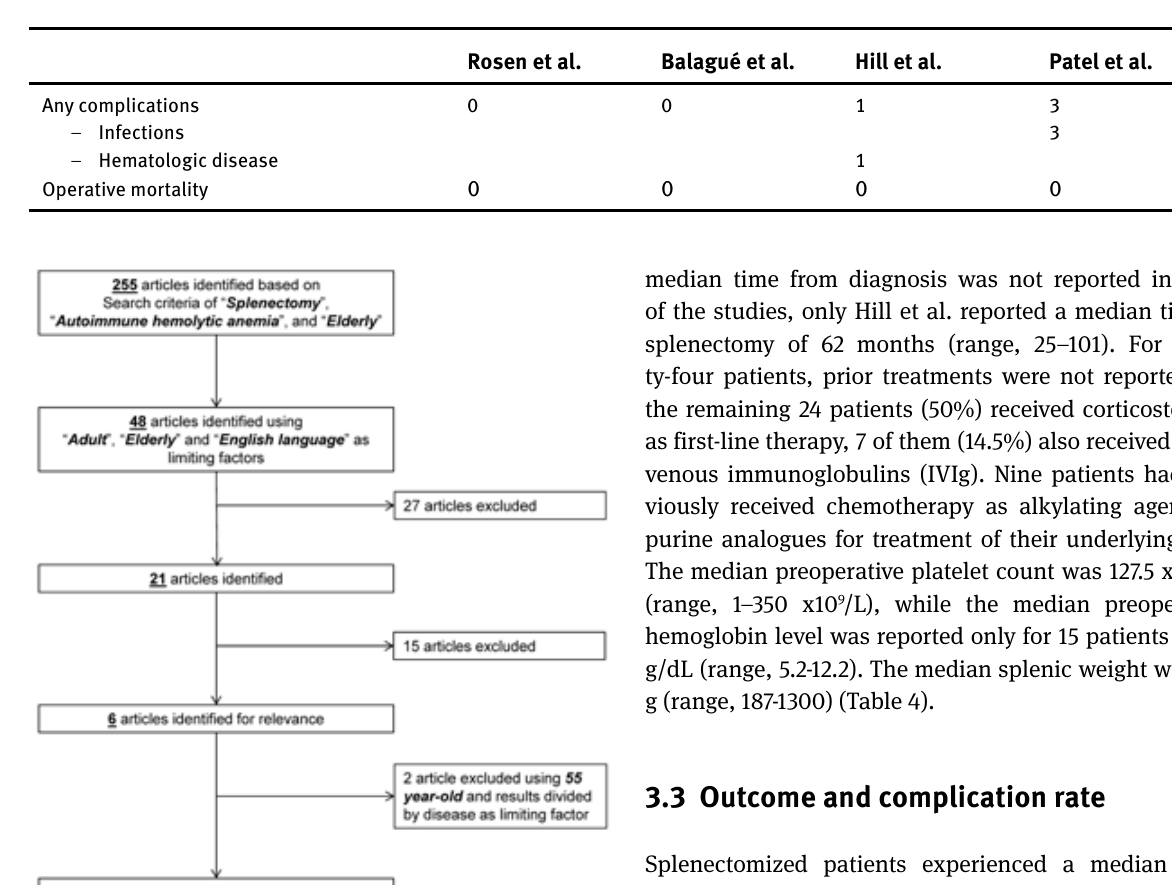
Table 6: Postoperative